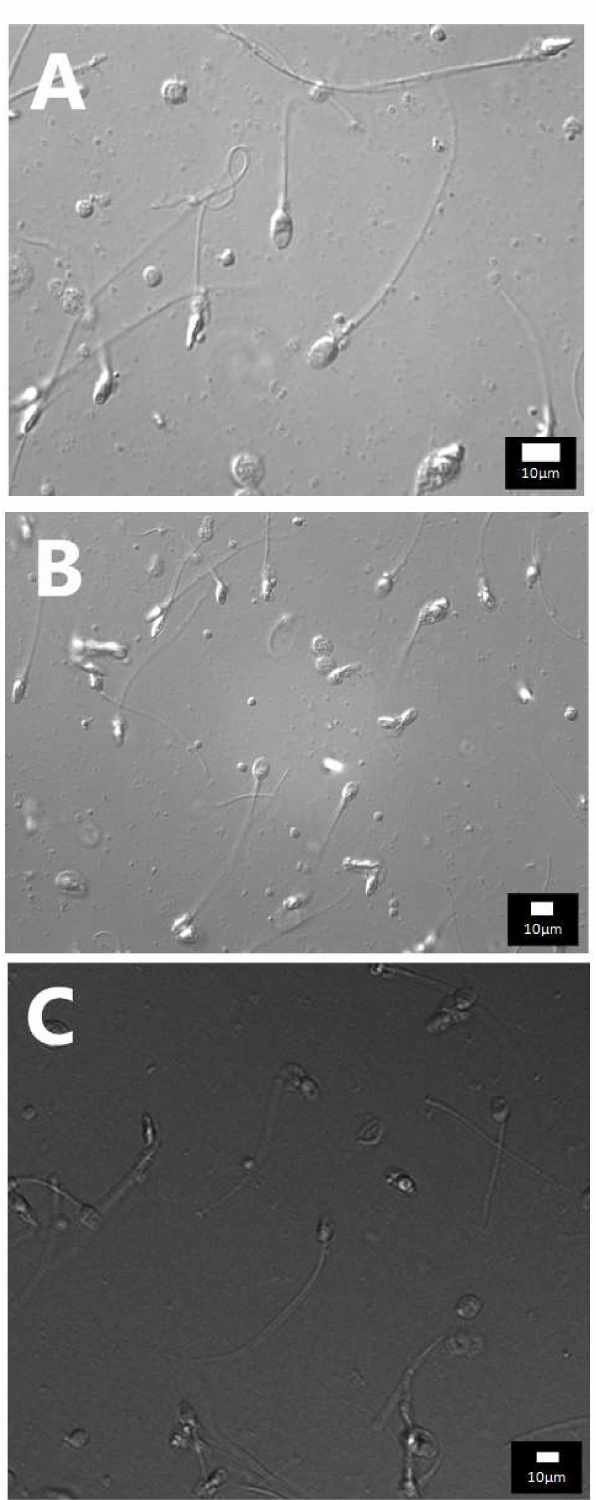
Figure A1. Photos of spermatozoa obtained with DIC using objectives with a high numeric aperture and various magnifications: ( A ) Leica DIC_100 × NA 1.4 OIL 550 nm (total magnification 1000 × ); ( B ) Leica DIC_63 × NA 1.4 OIL 550 nm (total magnification 630 × ); ( C ) Leica DIC_20 × NA 1.0 OIL 550 nm zoom 3 × (total magnification 600 × ). In either case, you can distinguish both large and small vacuoles in the sperm